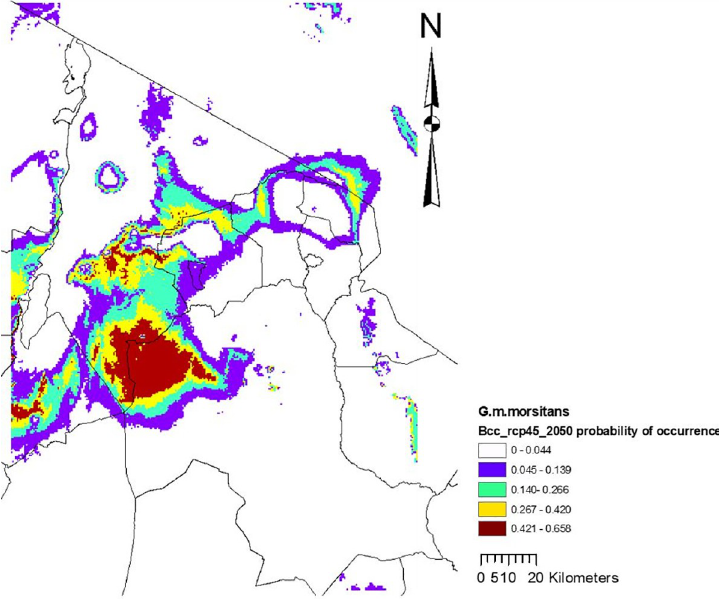
Fig 3. Midcentury (2050) climate suitability map for the best performing model with the G . m . morsitans occurrence data, and all 4 environmental variables: elevation, precipitation of the wettest month (April), mean maximum temperature of the warmest month (February), and mean minimum temperature of the coldest month (July). In these figure we see that the probability of occurrence decreases with time (comparing current and midcentury) from the maximum values of 0.845 to 0.658, with contracted habitat.